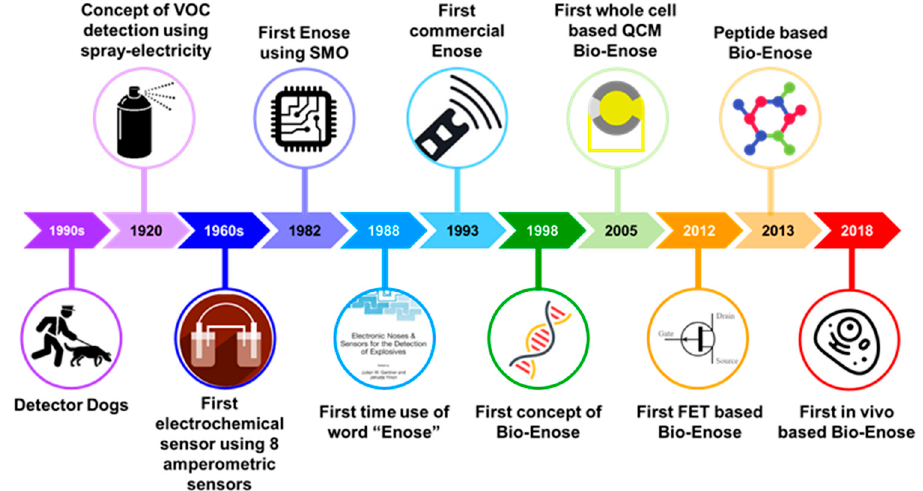
Figure 2. Major milestones in the development of Enose systems. VOCs: volatile organic compounds; SMO: semiconducting metal oxides; Enose: electronic nose; Bio-Enose: bioelectronic nose; QCM: quartz crystal microbalance; FET: field effect transistor.